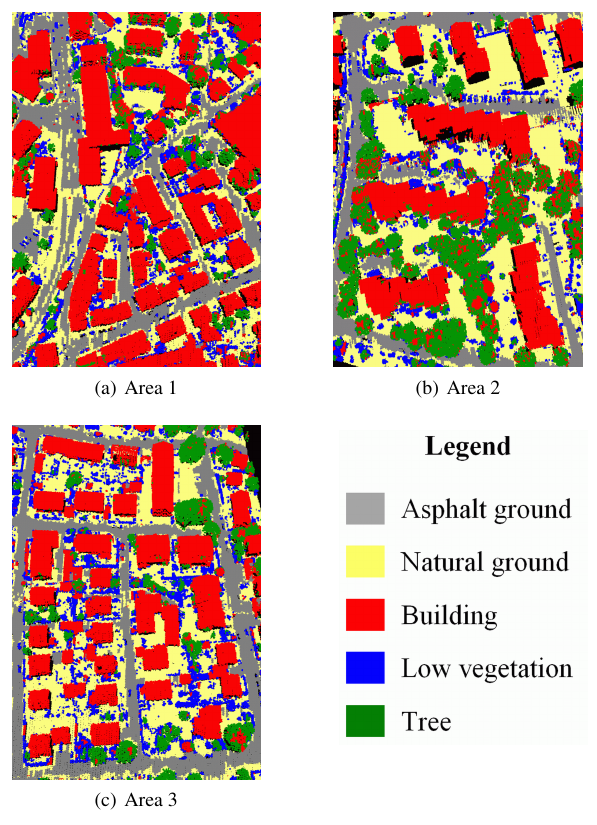
Figure 2: 3D CRF-Classification results.